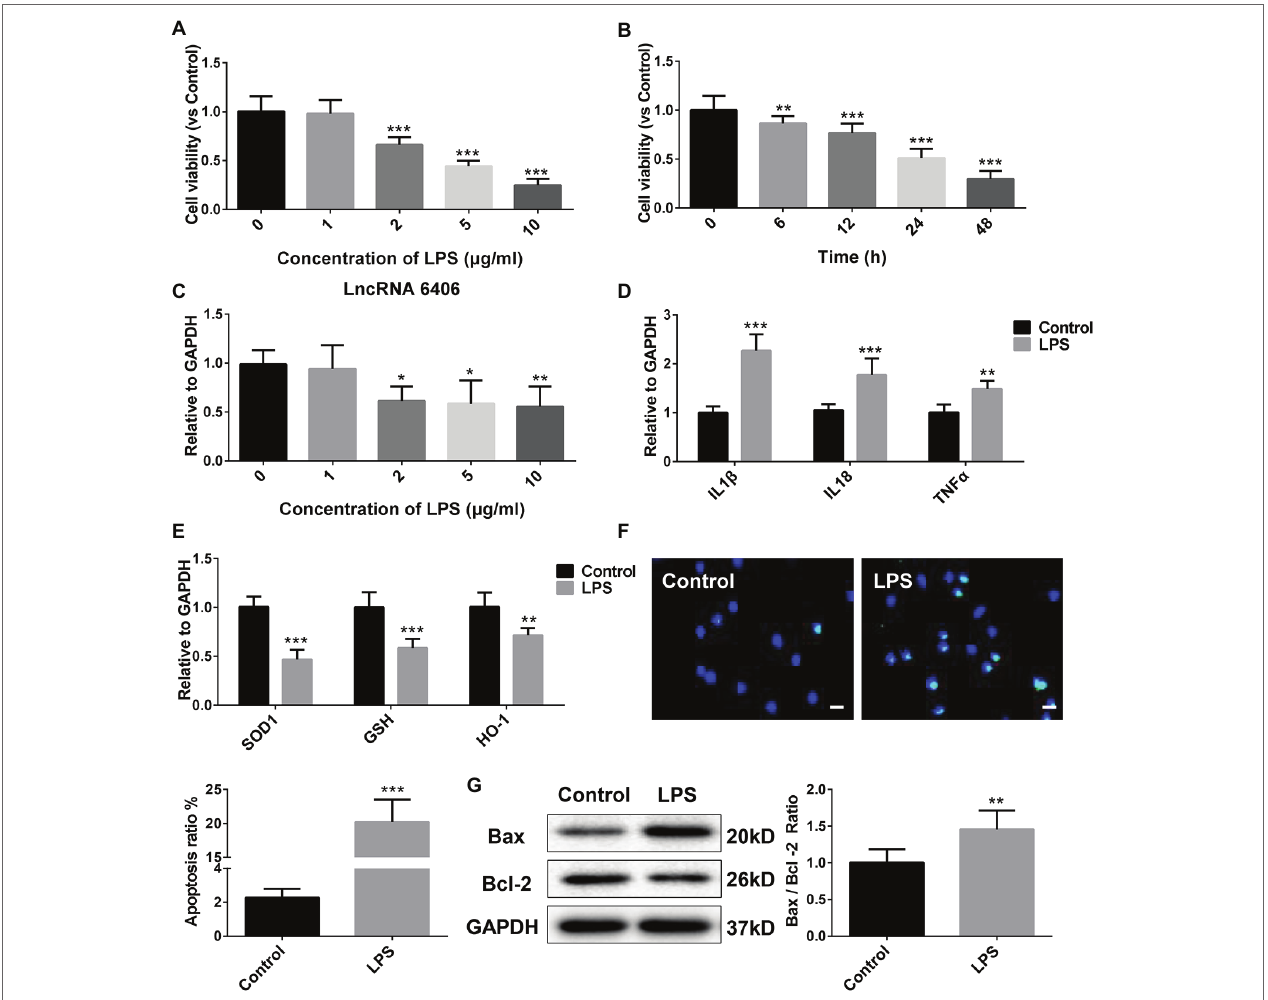
FIGURE 2 | The downregulation of LncRNA 6406 was determined in an in vitro cell model of LPS-induced AKI. (A,B) The viability of PTEC cells was evaluated after exposure to different concentrations of LPS (0, 1, 2, 5, and 10 μ g/ml) for 24 h and after exposure to 2 μ g/ml LPS for different time points (0, 6, 12, 24, and 48 h) ( n = 6). (C) The relative expression was determined after exposure to LPS at different concentrations ( n = 6). (D) The relative expression of inflammatory cytokines was detected in the LPS-stimulated AKI cell model. (E) Oxidative stress in the PTEC cells was determined after LPS stimulation by RT-PCR analysis ( n = 6). (F,G) Apoptosis in the PTEC cells were evaluated via TUNEL assay and western blot analysis ( n = 6), scale bar = 10 μ m. Each experiment was conducted independently three times. *p < 0.05; **p < 0.01; ***p < 0.001; versus respective